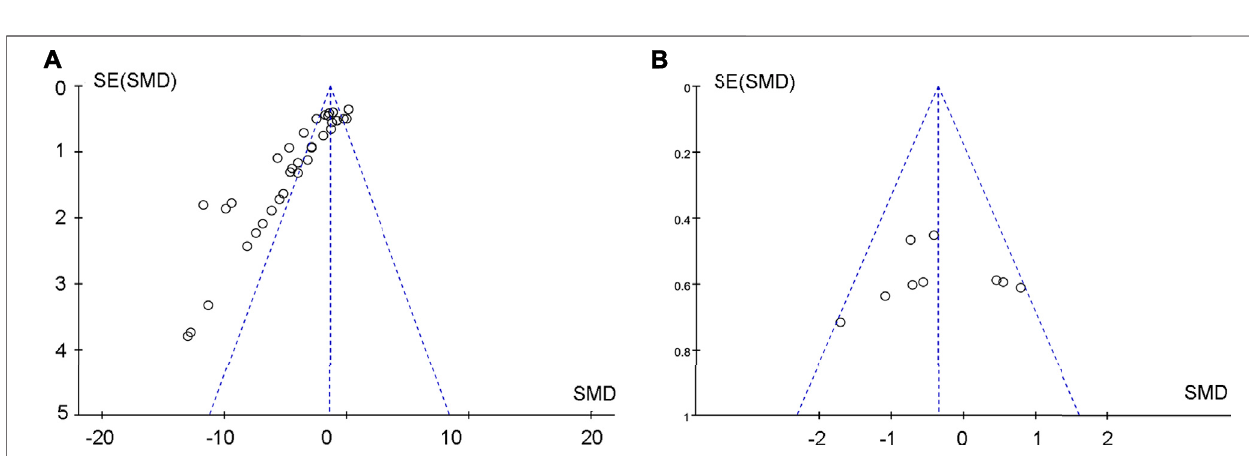
Frontiers in Pharmacology |